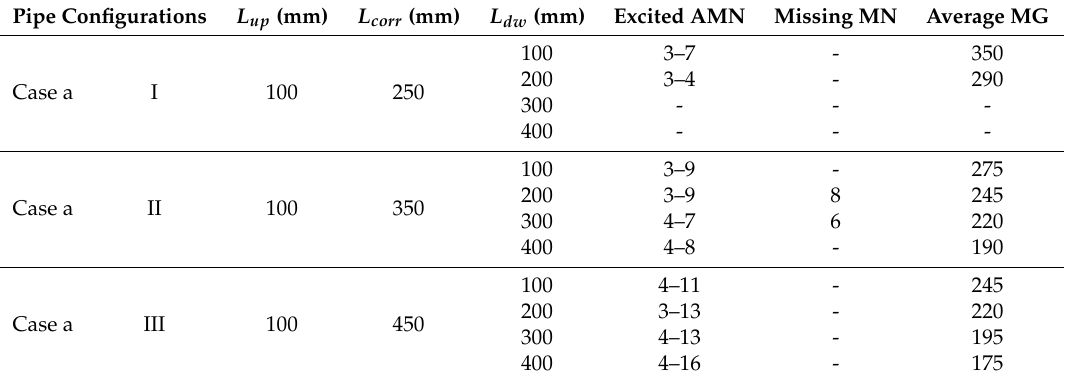
Table 19. Excited acoustic mode numbers, mode numbers within the whistling range at which there was no whistling, and average mode gap between two successive modes for all configurations included in Case a. In the table, MN and MG denote Acoustic Mode Numbers and Mode Gap (Hz), respectively.